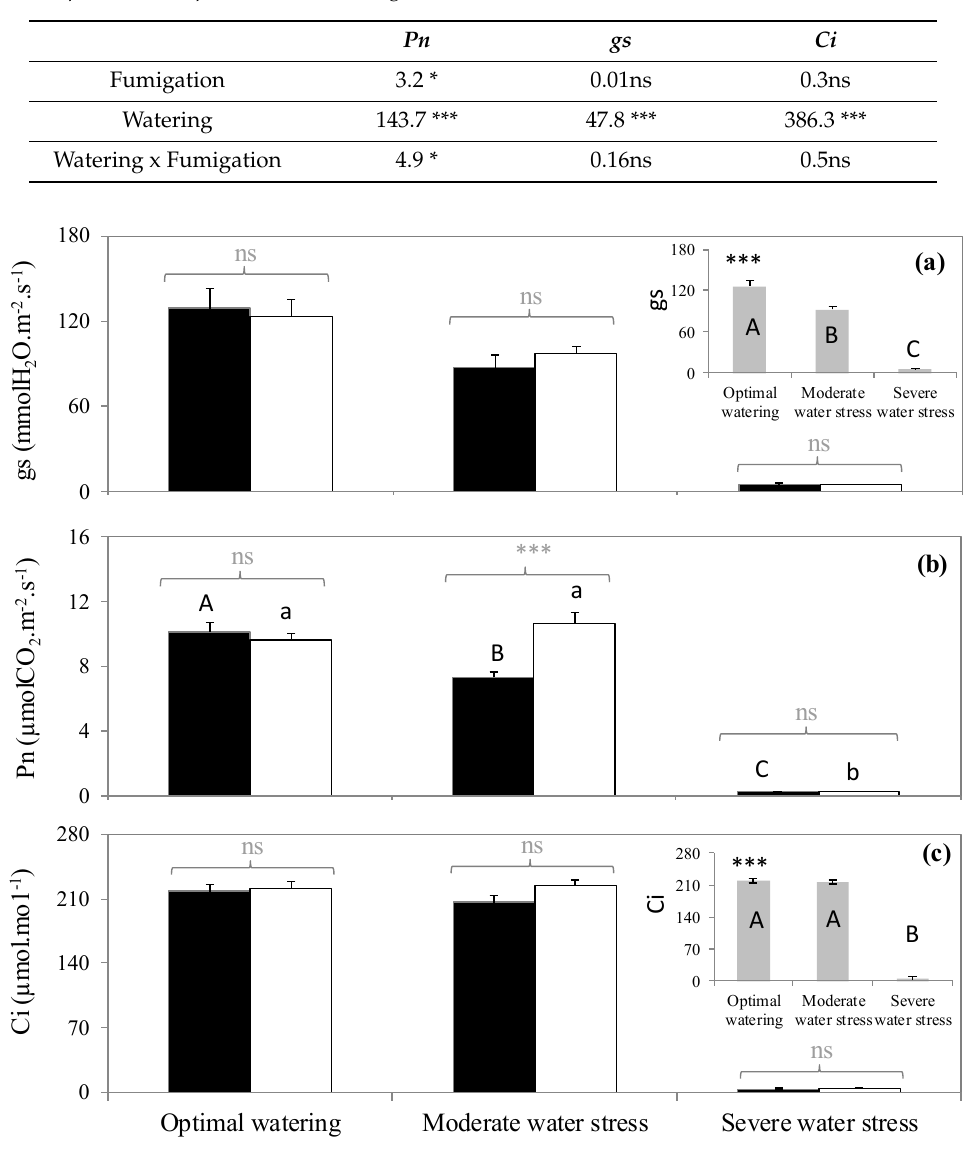
Figure 1. ( a ) Stomatal conductance to water, ( b ) net photosynthesis, and ( c ) intercellular CO 2 Figure 1. ( a )Stomatalconductancetowater, ( b )netphotosynthesis, and( c )intercellularCO 2